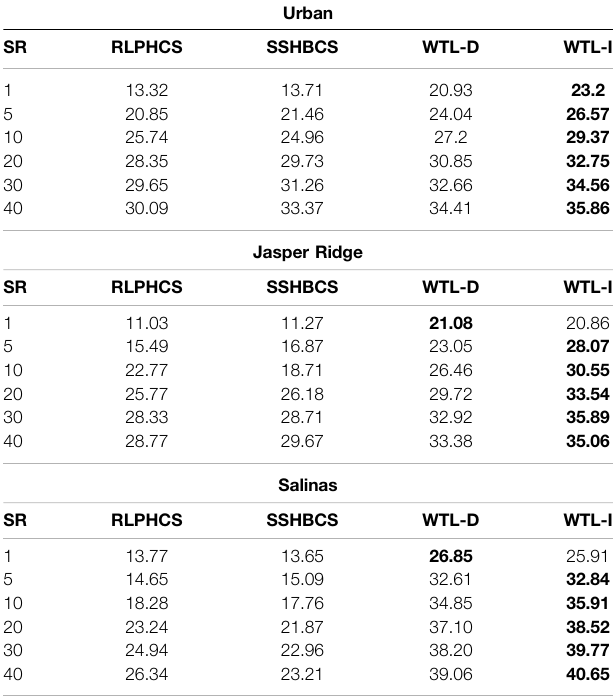
TABLE 2 | PSNR of reconstructed HSI with WTL-D, WTL-I, SSHBCS, and RLPHCS (best results are highlighted). The noise level is 20 dB.